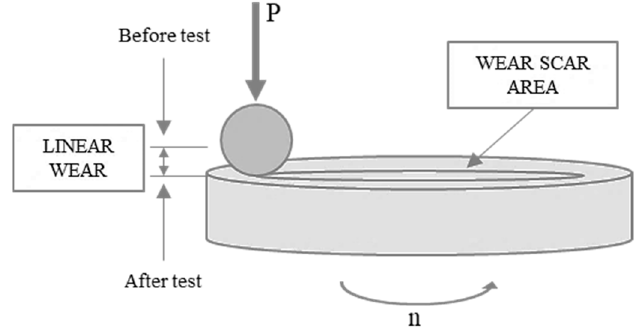
Figure 1. Tribological measurements.